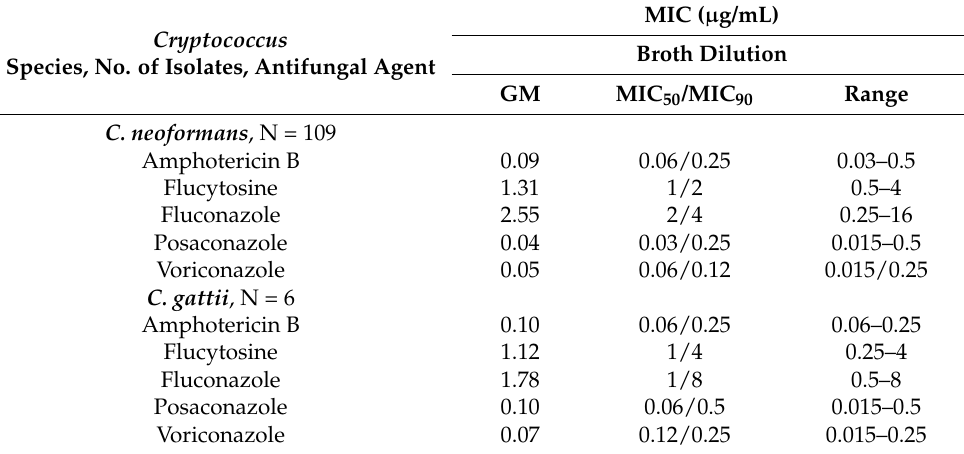
Table 1. In vitro susceptibility of clinical isolates of Cryptococcus neoformans and C. gattii to five antifungal agents as determined by CLSI broth